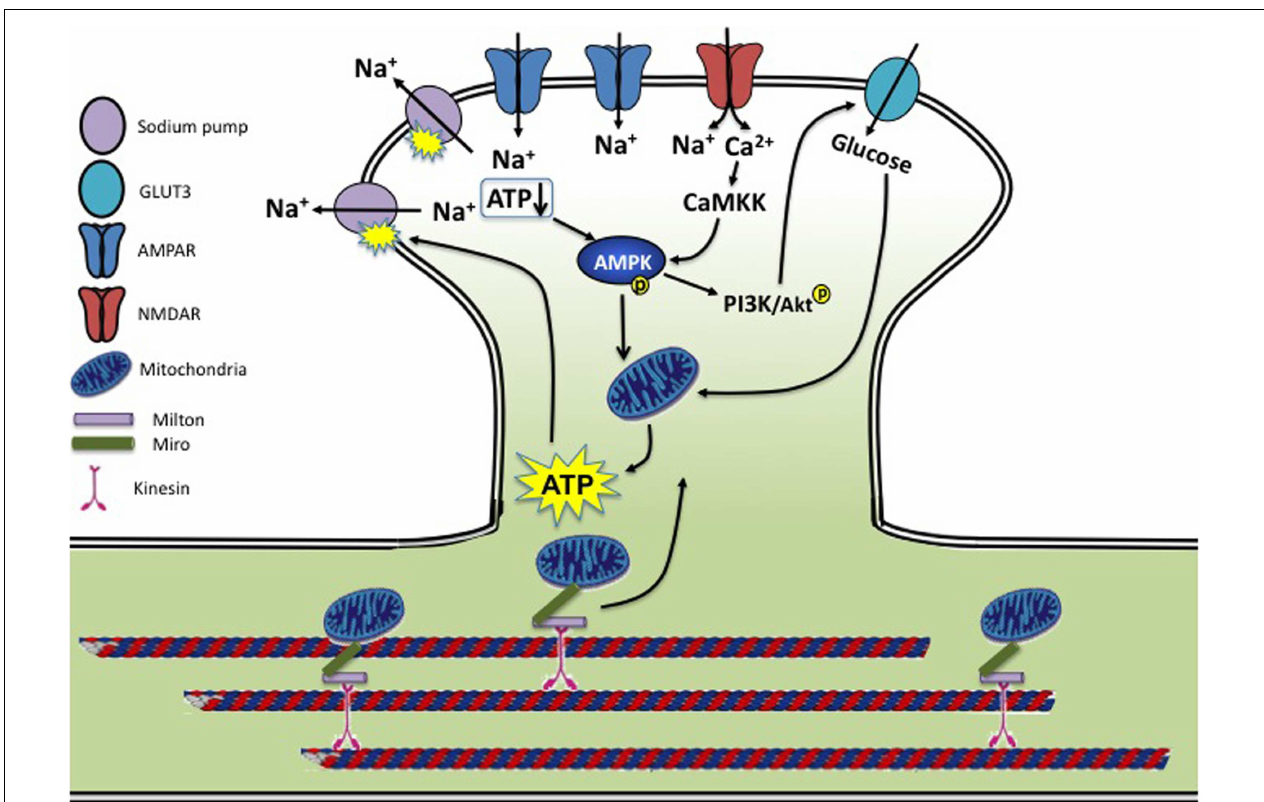
Milton/Miro-mediated kinesin motor complex. In conditions of neurotrauma and neurodegenerative diseases, several aspects of this regulation may be disrupted. During hypoxia, ischemia, and stroke, insufficient ATP levels cause dysfunction of the sodium pump, leading to a loss in membrane potential and neuronal function. AD brains show reduced levels of GLUT3, and both AD and HD brains have a reduced rate of neuronal glucose metabolism. Mouse models of AD and PD show mitochondrial dysfunction along with reduced mitochondrial motility, preventing proper mitochondria delivery to the synapse and leading to decreased energy metabolism. Brains of traumatic injuries show reduced ATP levels and suppressed mitochondrial